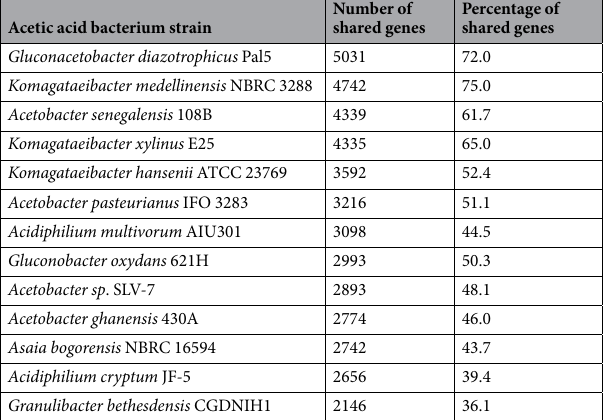
Number of shared genes